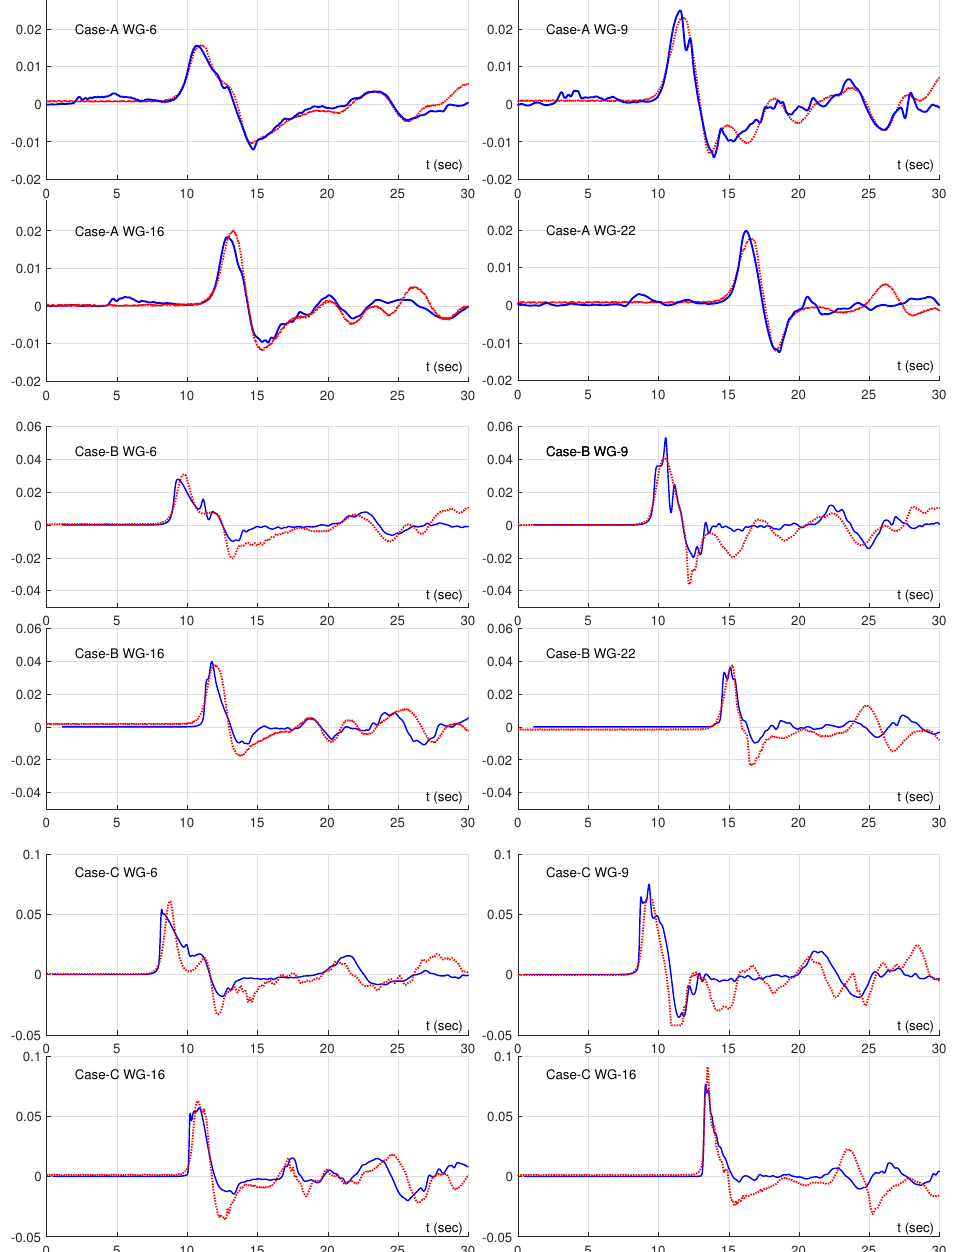
Figure 9. Surface elevation at WG-6, WG-9, WG-16, dan WG-22. Numerical results (blue solid line) and experimental data (red dotted line). (Top) Case A ( H / d = 0.045 ) , (Middle) Case B ( H / d = 0.09 ) , (Bottom) Case C ( H / d = 0.18 )